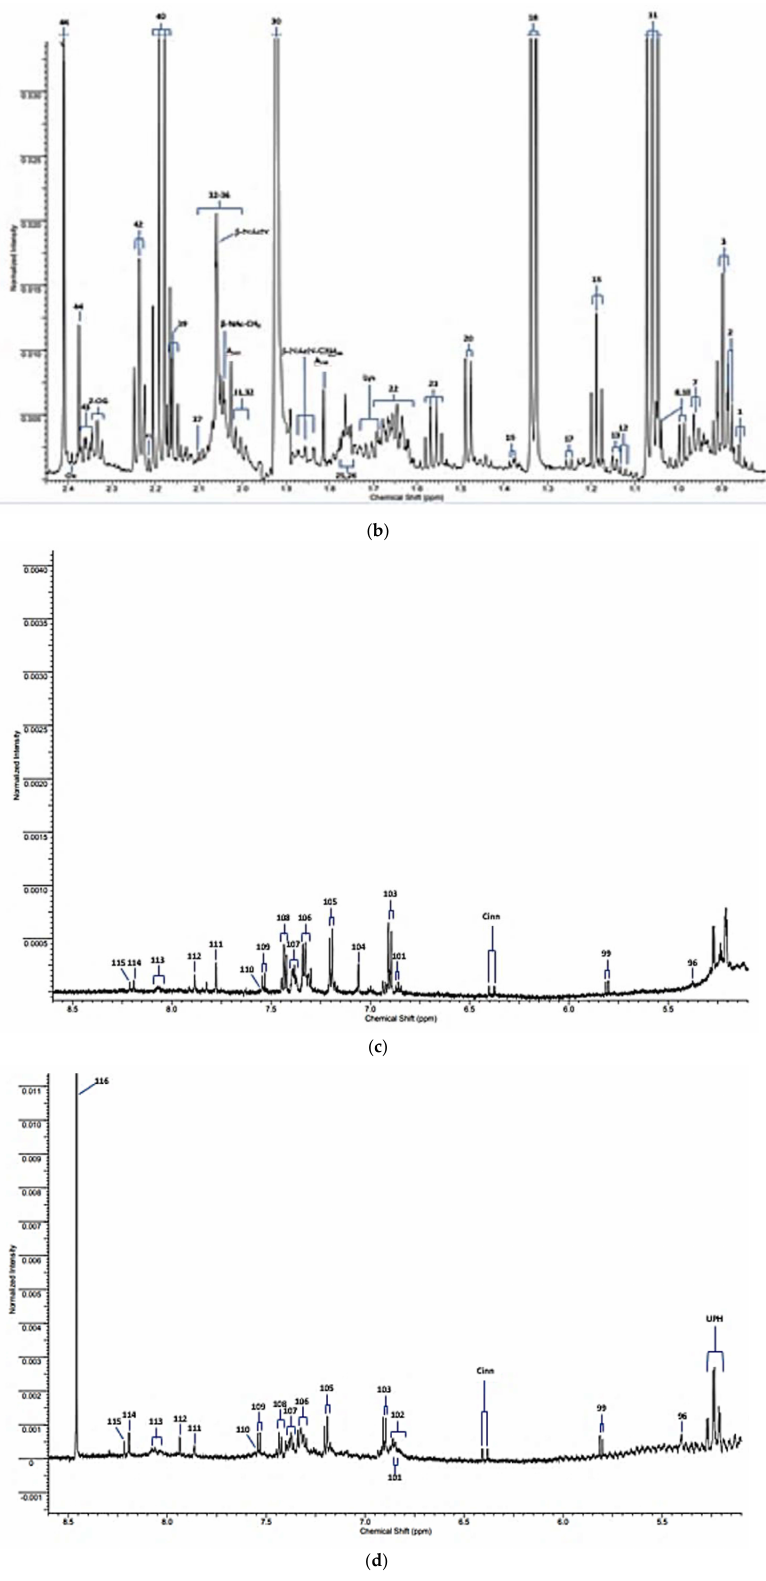
Figure 4. ( a ) and ( b ), 0.80–2.45 ppm regions of the 600 MHz single-pulse noesy-presat 1 H NMR profiles of WMS supernatant samples donated by healthy and acute sore throat disease human participants, respectively. ( c ) and ( d ), Corresponding 5.10–8.60 ppm regions of these spectra, respectively. Typical spectra are shown. Abbreviations: Assignment codes correspond to those listed in Table 1, along with a small number of tentative assignments. Spectra were acquired as described in Section 5.3 above.